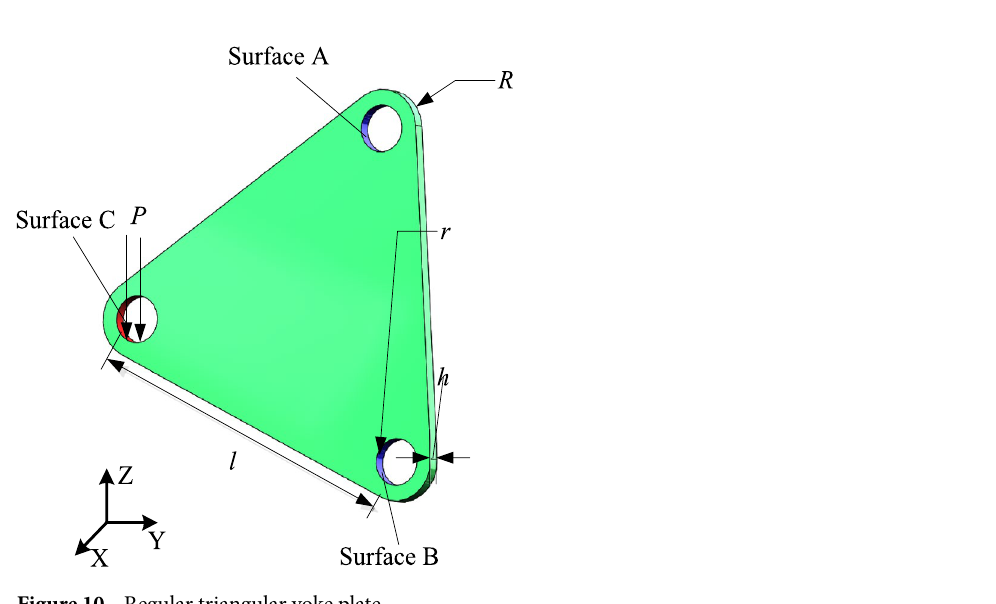
Figure 10. Regular triangular yoke